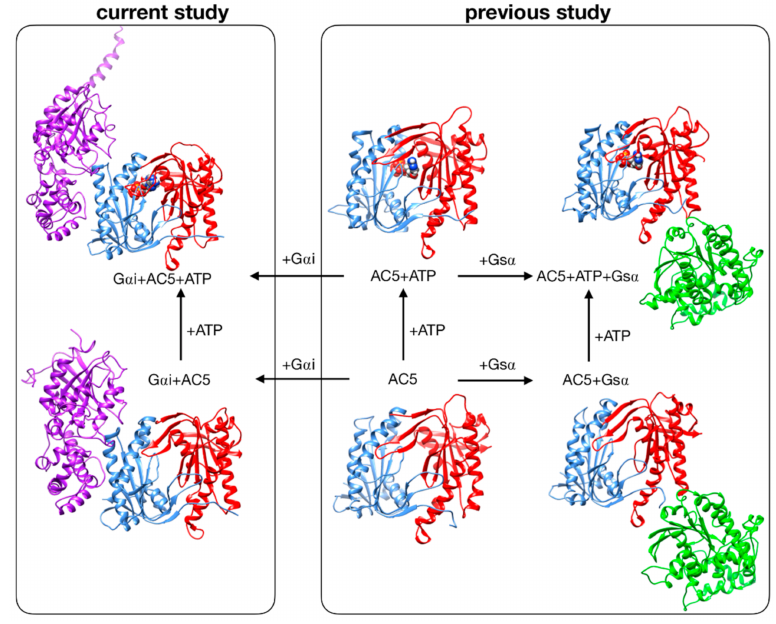
Figure 1. Structure of the cytoplasmic segment of the AC5 isoform of adenylyl cyclase and of its complexes with ATP and the regulating G-proteins Gs α and G α i viewed from the side closest to the cell membrane. Proteins are shown as backbone ribbons. The C1 and C2 subunits of AC5 are colored blue and red respectively, Gs α is colored green, and G α i is colored purple. ATP is shown in a CPK representation with standard chemical coloring. In each case, the structures are averages taken from the molecular dynamics simulations. For the AC5 in complex with G α i with and without ATP, we chose one of the docking poses we used in this